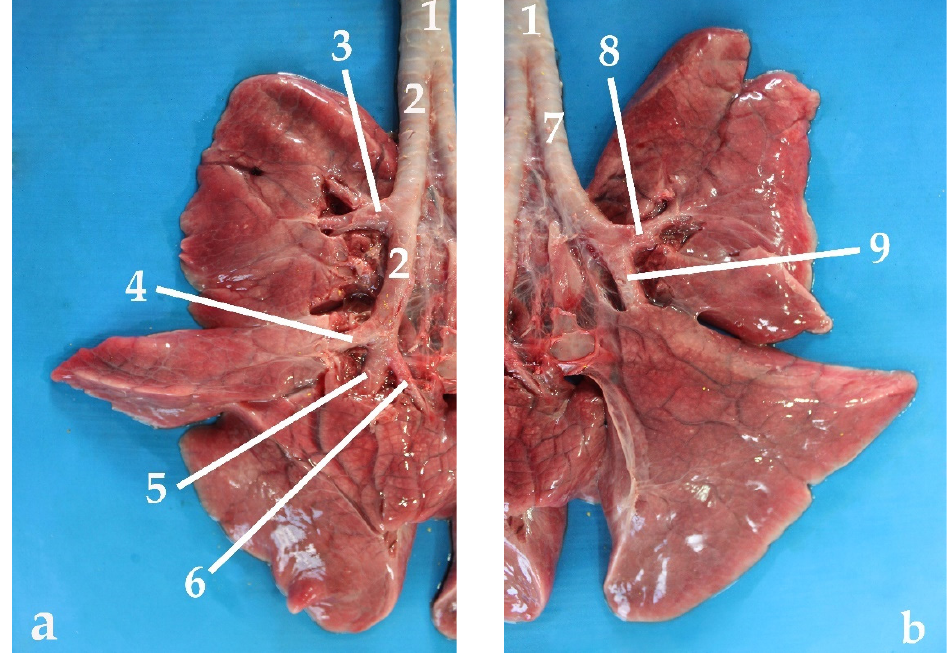
Figure 9. Ventral view of the lung: ( a ) right lung; ( b ) left lung; (1) trachea; (2) right main bronchus; (3) right cranial lobar bronchus; (4) right mid lobar bronchus; (5) right caudal lobar bronchus; (6) accessory lobar bronchus; (7) left main bronchus; (8) left cranial lobar bronchus; (9) left caudal lobar bronchus. Table 2. The morphometric data of the bronchi from the 11 individuals of Arctocephalus australis investigated in the present study. A: adult; J: juvenile.